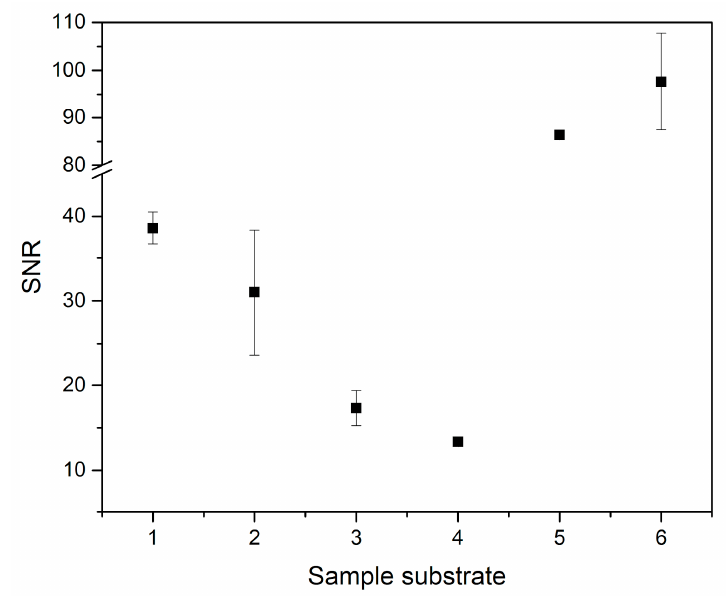
Figure 5. The dependence of signal-to-noise ratio of zinc drops on the type of sample substrate: 1—BAM 310, 2—radish (Raphanus Sativus L.), 3—polystyrene, 4—aluminum foil, 5—glass slide, 6—mouse kidney slice.